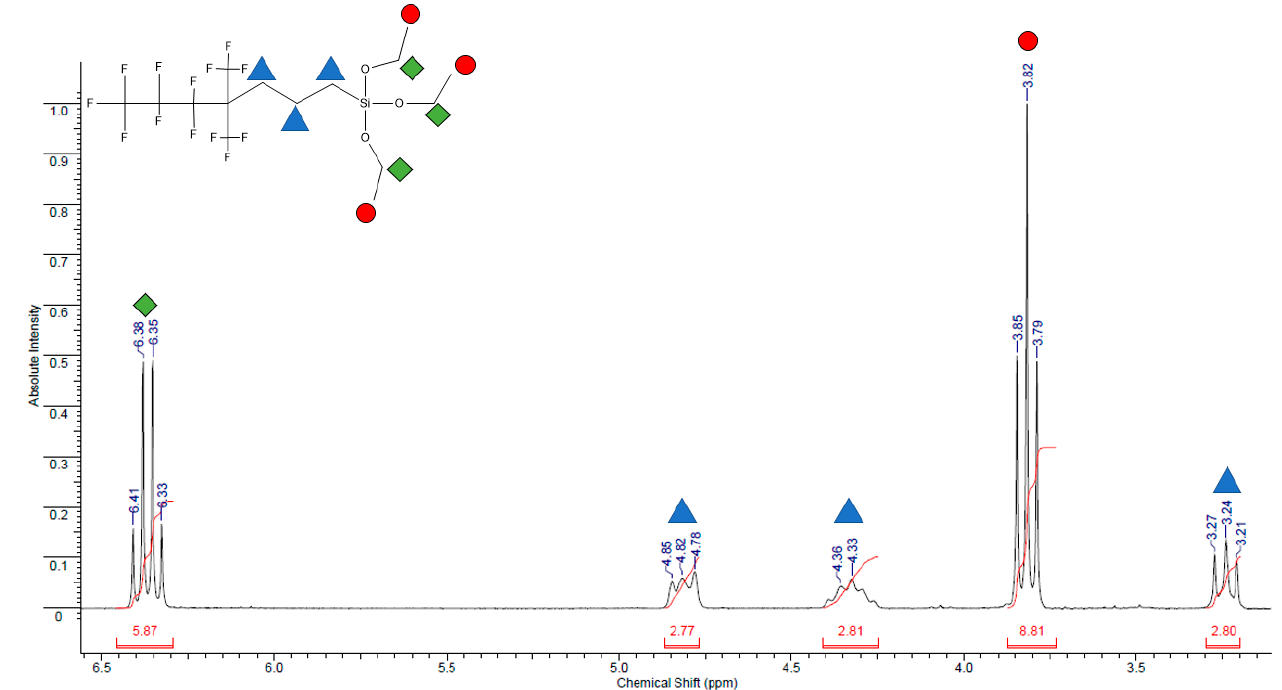
Figure 3. NMR spectrum of 1,1,1,2,2,3,3-heptafluoro-4,4-bis(trifluoromethyl)pentyltriethoxysilane 1 H NMR (70 MHz, C 6 F 6 ), δ , m.d. = 3.24 (t, 2H, J = 8.3 Hz, CH2), 3.82 (t, 9H, J = 7.0 Hz, OCH 2 CH 3 ), 4.32-4.36 (m, 2H, CH 2 ), 4.82 (t, 2H, J = 8.3 Hz, CH 2 ), 6.38 (q, 2H, J = 7.0 Hz, OCH 2 CH 3 ).